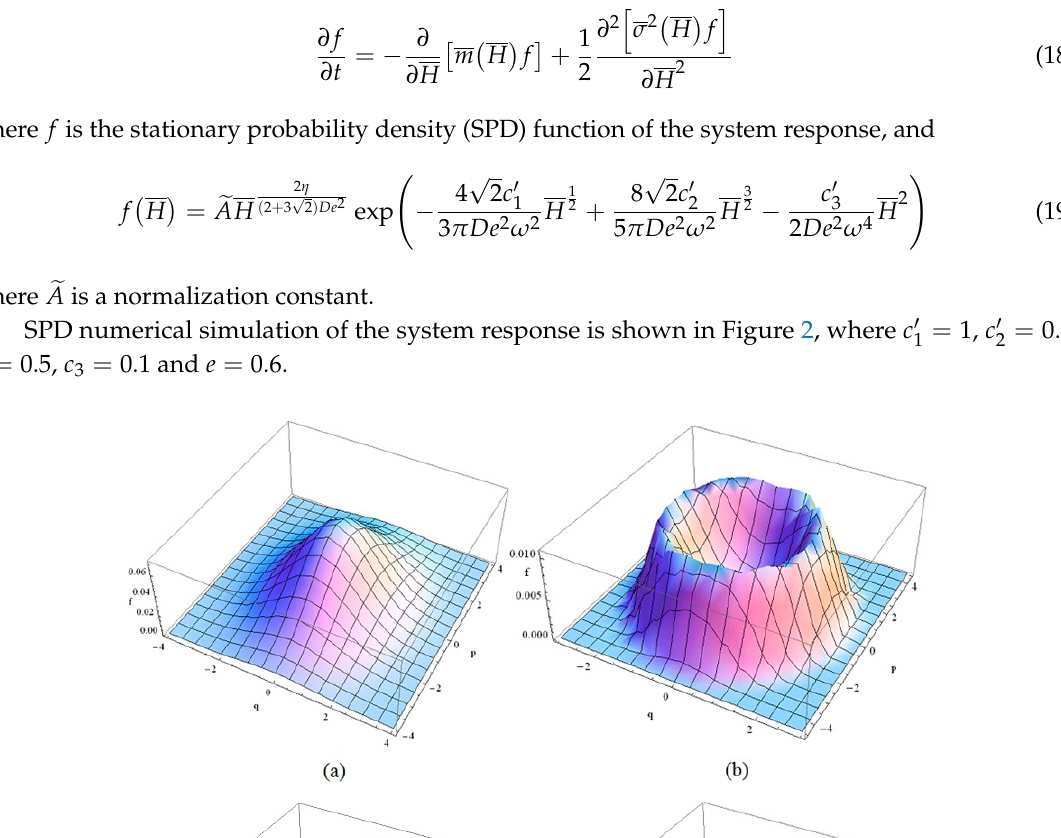
Figure 3. System heteroclinic orbits.